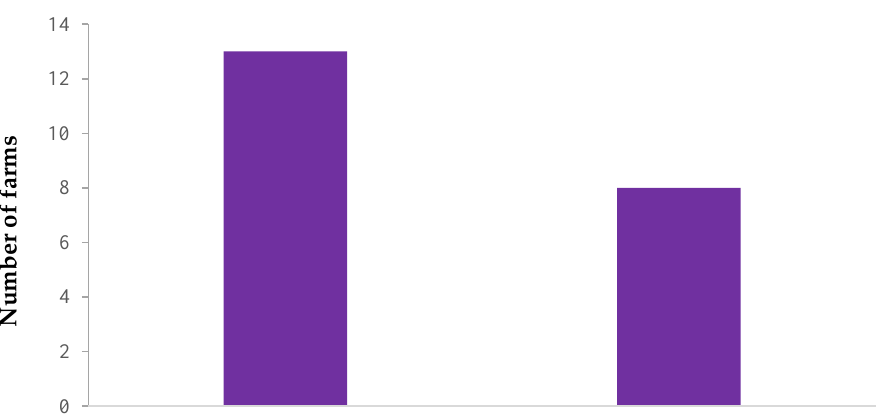
Figure 4. The frequency of situations likely to lead to contact between livestock and bats on farms visited.